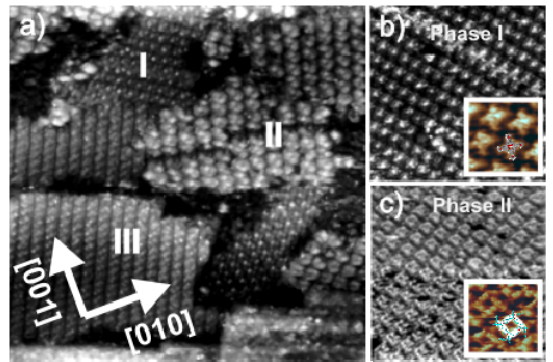
Figure 13. ( a ) Large scale in situ STM image illustrating three distinct phases forming on the Cl/Cu(100) electode surface : 61.46 nm × 61.46 nm, U E = +10 mV; ( b ) Typical square phase of the [H electrode surface (phase I): 23.23 nm × 23.23 nm, U E = +10 mV; Inset image: 4.95 nm × 4.95 nm, U ( c ) Characteristic medium scale and high resolution STM images of a DBV 2+